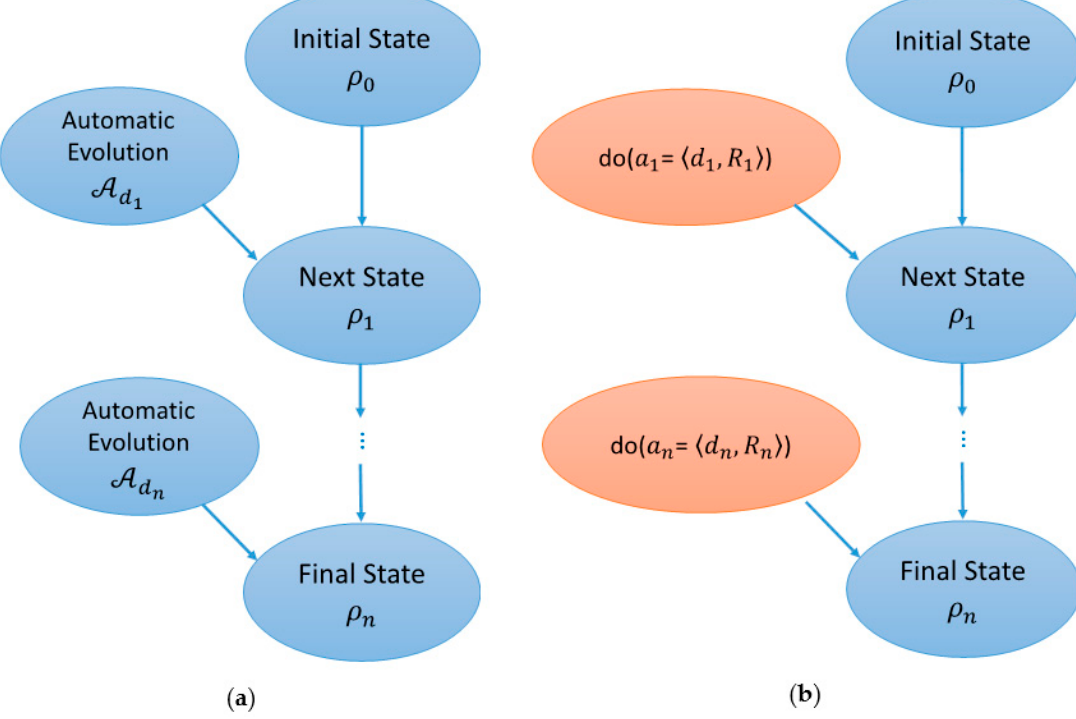
Figure 1. Quantum theory as interventionist causal theory: ( a ) With automatic evolution, ρ k has ρ k − 1 with probability 1; ( b ) on intervention do ( a k = (cid:104) d k , R k (cid:105) ), the state ρ k − 1 transforms value A d k